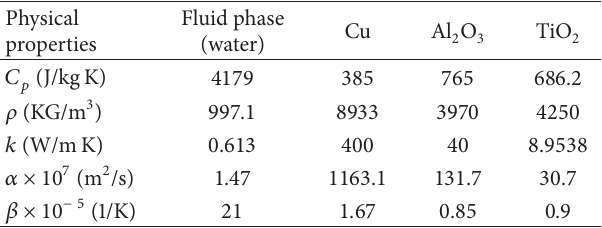
Table 2: Thermophysical properties of fluid and